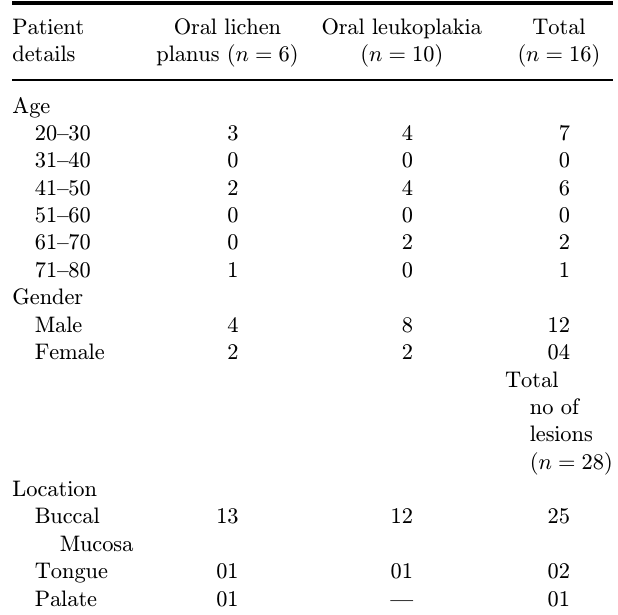
Table 1. Distribution details of the study population for OLP and OL Patients.